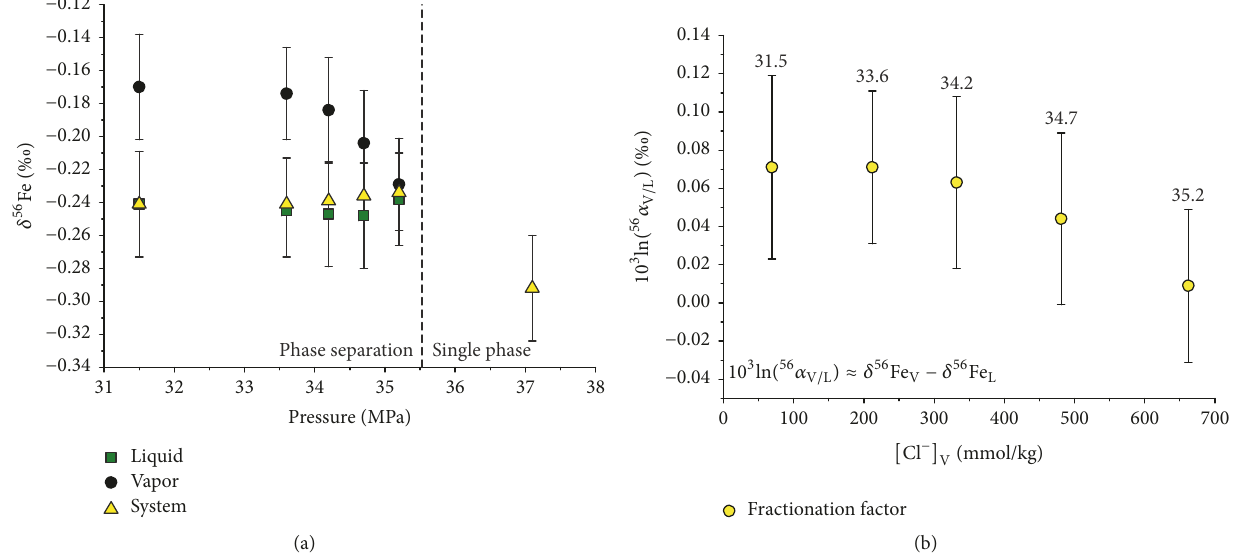
Figure 3: Fe isotope compositions and fractionations of the vapor, liquid, and integrated system during decompression (after [63]).